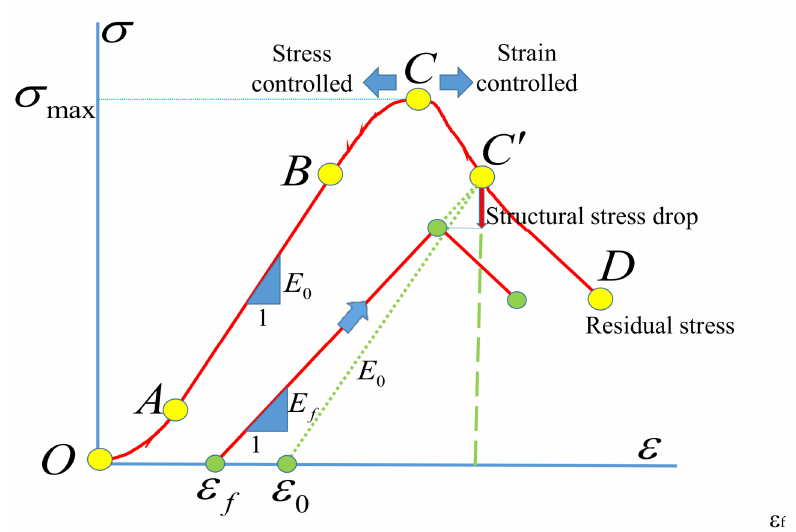
Figure 13. Constitutive law of structural unloading.